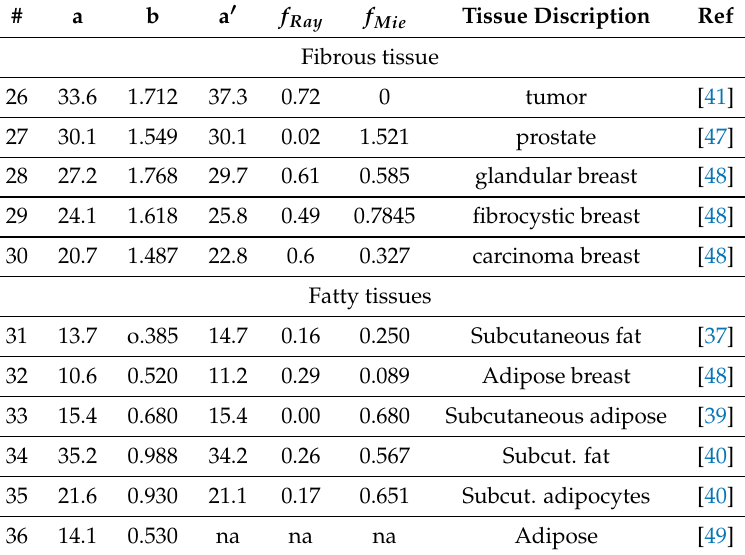
Table 2. Represents the different tissues (e.g., fibrous and fatty) description using scattering parameters, where a is the µ s (cid:48) value at the reference wavelength and b is the characteristic power dependence and f Ray or f Mie demonstrated the fraction of small and large scatterers, respectivelypectively. # a b a (cid:48) f Ray f Mie Tissue Discription